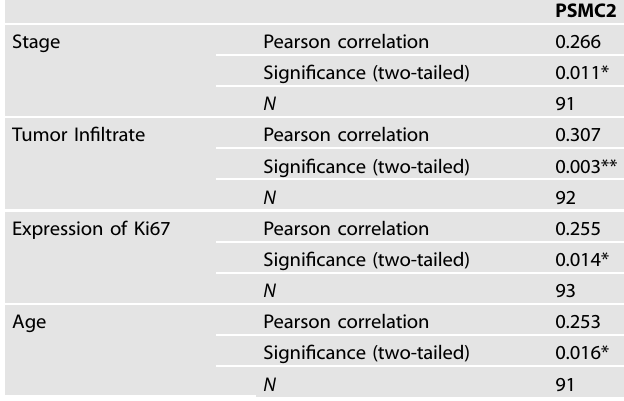
Table 3. Relationship between PSMC2 expression and tumor characteristics in patients with gastric